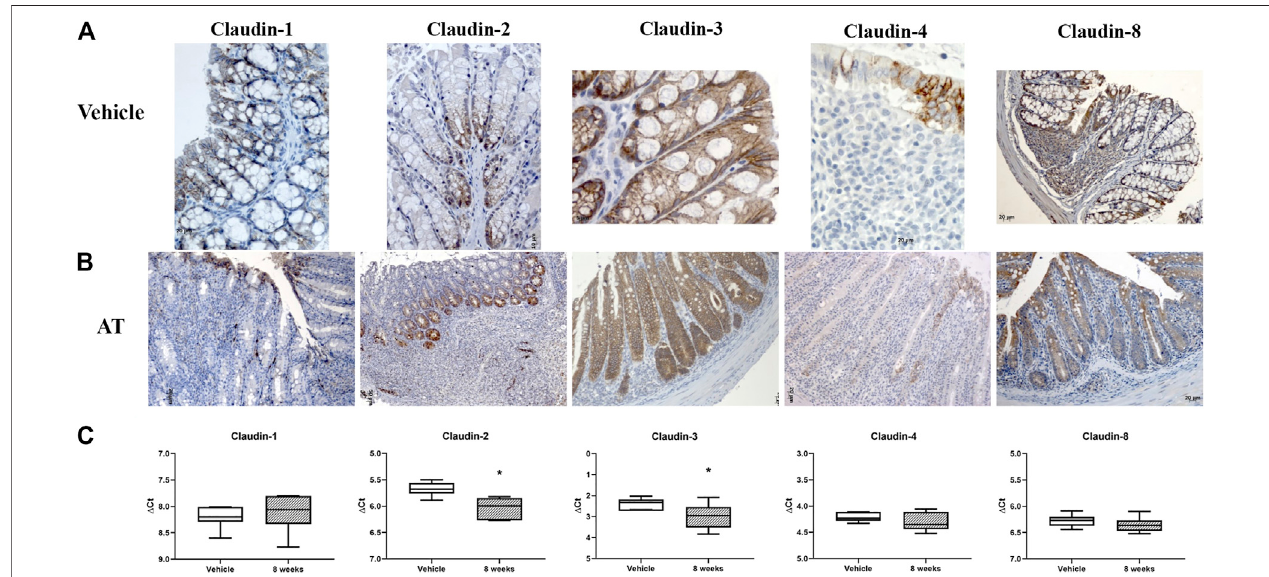
FIGURE 12 | Claudin-1, claudin-2, claudin-3, claudin-4, and claudin-8 expression in adoptive transfer murine model of IBD. (A) Overview of claudin-1, claudin-2, claudin-3, claudin-4, and claudin-8 expression pattern (IHC), in naive SCID mice; (B) overview of claudin-1, claudin-2, claudin-3, claudin-4, and claudin-8 expression pattern (IHC) in adoptive transfer model, 8 weeks after transfer; (C) claudin mRNA expressed as Δ CT value from claudin CT normalized to the GAPDH CT. Data are presented as box-and-whisker plots, with median and whiskers extending from 5 to 95 percentiles (one representative experiment: seven naive animals and nine animals sacri fi ced 8 weeks after transfer). t Test, p < 0.05 vs. naive mice; AT, adoptive transfer